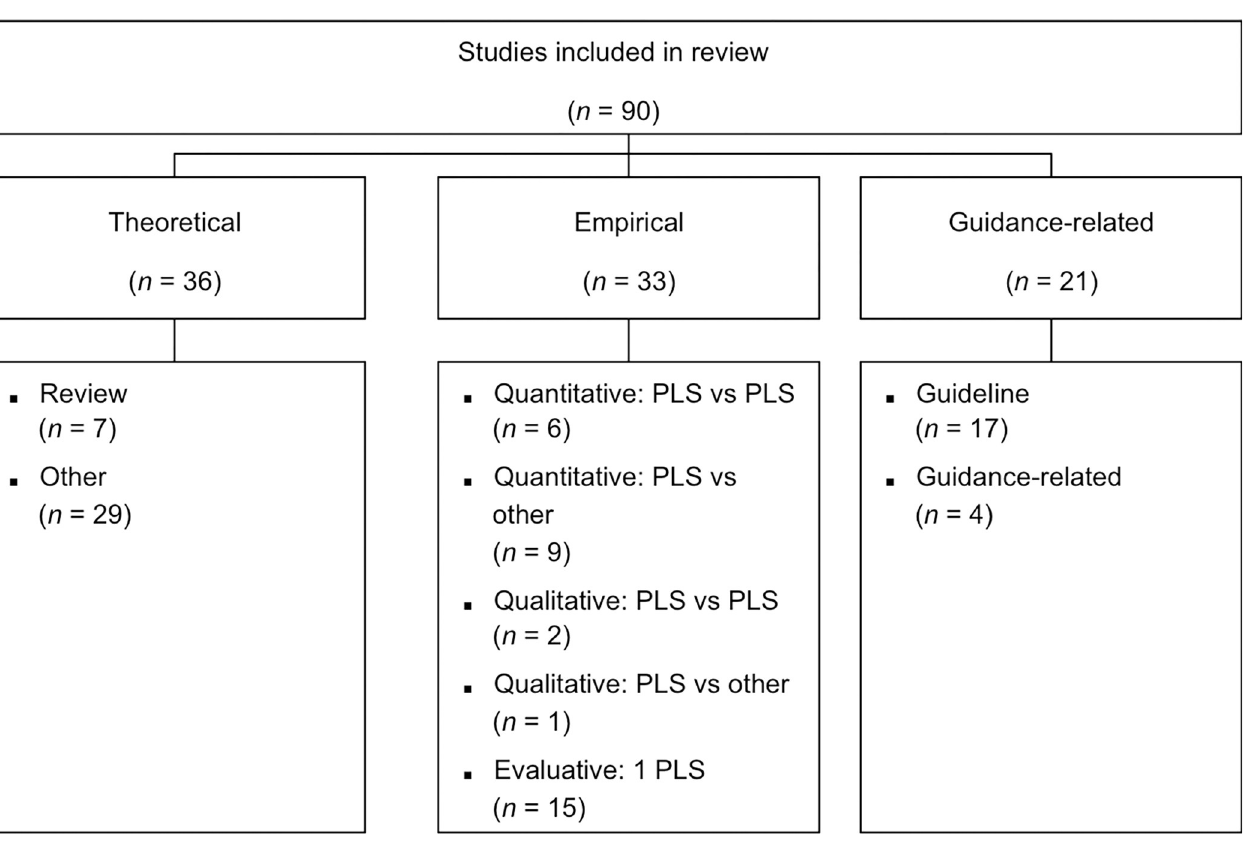
Fig 2. Study types of studies included in this